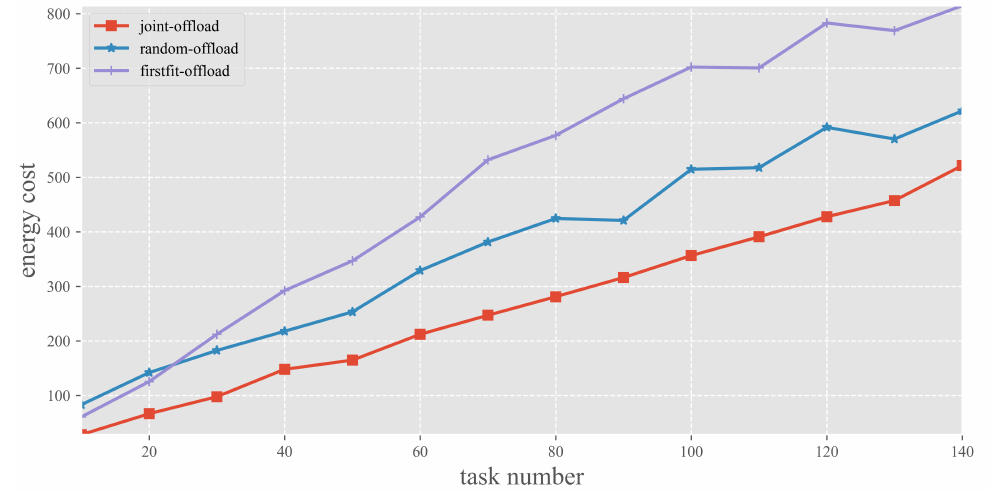
Figure 13. Energy cost of the three offloading strategies varies with the number of tasks in the whole constellation offloading scenario.